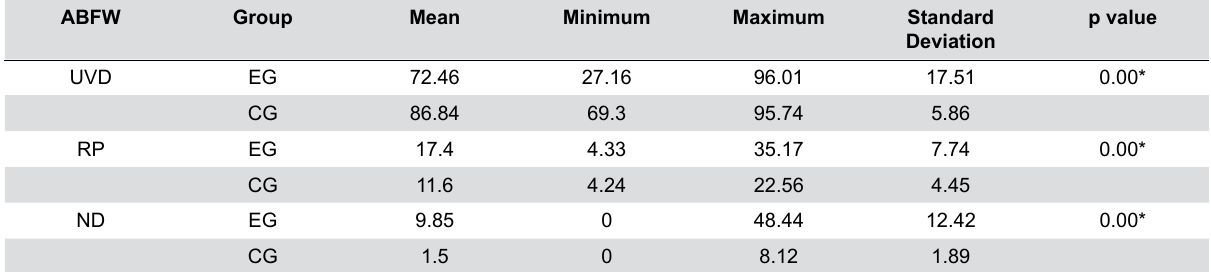
Table 2- Results of the ABFW instrument of the PG compared to the CG